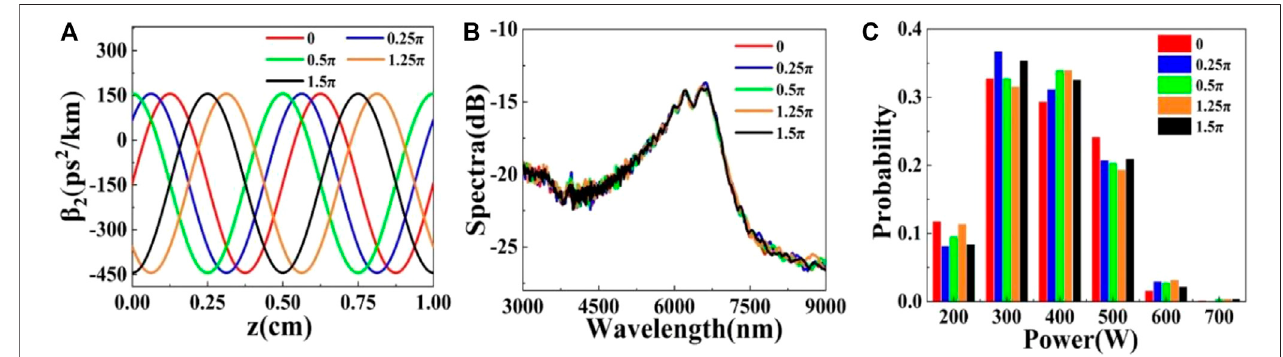
FIGURE 7 | (A) Dispersion curves, (B) output mean spectra, (C) histograms of the peak power beyond 7,000 nm of the output spectra in DOF with different initial phases ( P